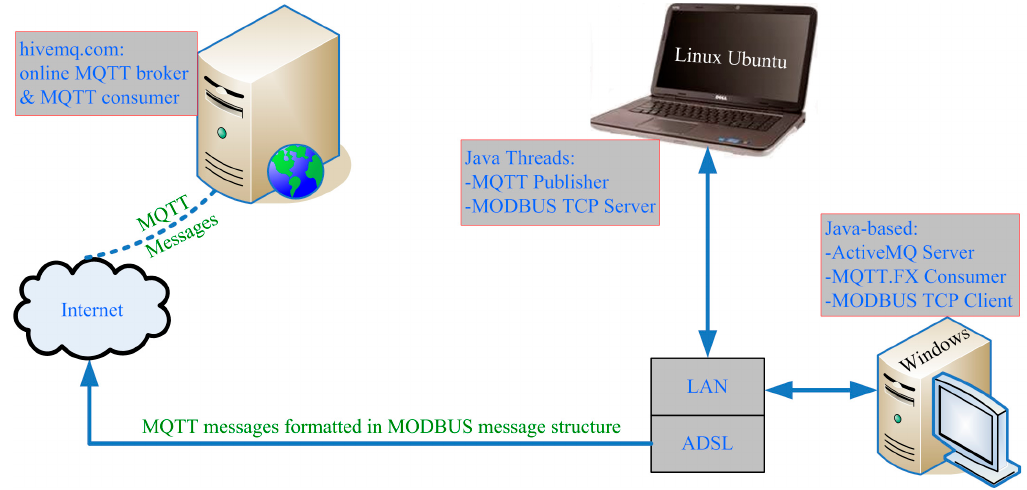
Figure 11. Simulation environment of the second scenario.